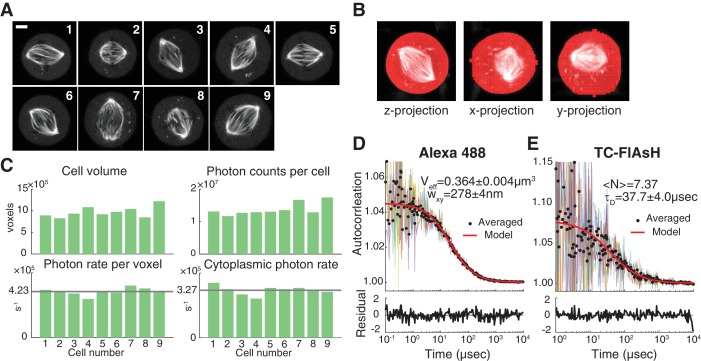
β-tubulin labeling fraction measurement.(A) Two-photon fluorescent microscopy images of 9 mitotic cells with β-tubulin-TC-FlAsH. 5 μm scale bar. (B) Example 3D segmentation using active contour algorithm. (C) (top left) The number of voxels in segmented 3D cell images, (top right) the total number of photons collected from entire cells, (bottom left) the total number of photons divided by the number of voxels and the measurement time, and (bottom right) the number of photons collected per second at a voxel in the cytoplasmic region. Gray lines are the average over the 9 different cells. (D) and (E) FCS measurements on Alexa Fluor 488 and TC-FlAsH in solution, respectively. Black circles are averaged over 5 or 6 autocorrelation functions, and red lines are a single-component FCS model fit to the averages. Corresponding weighted residuals (the difference between data and model, divided by the standard deviation of data) are plotted below to show any systematic deviations of the fitted models from the data.